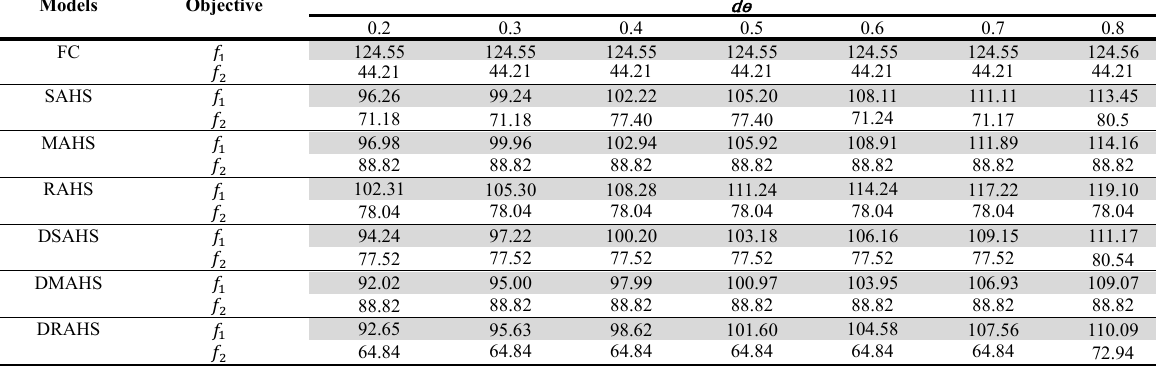
Performance of optimal solutions for different value of d ѳ Models